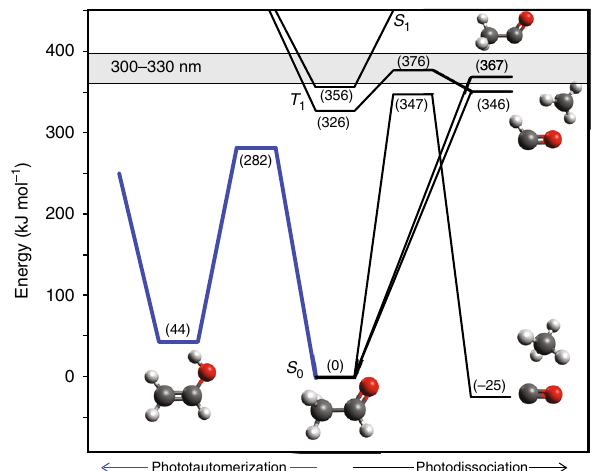
Fig. 2 Simpli fi ed potential energy diagram. Stationary points describing photochemical pathways of acetaldehyde following excitation at actinic wavelengths of 300 – 330nm (gray band). Energies obtained from refs. 33 – 37 , isomerization of acetaldehyde to vinyl alcohol indicated in